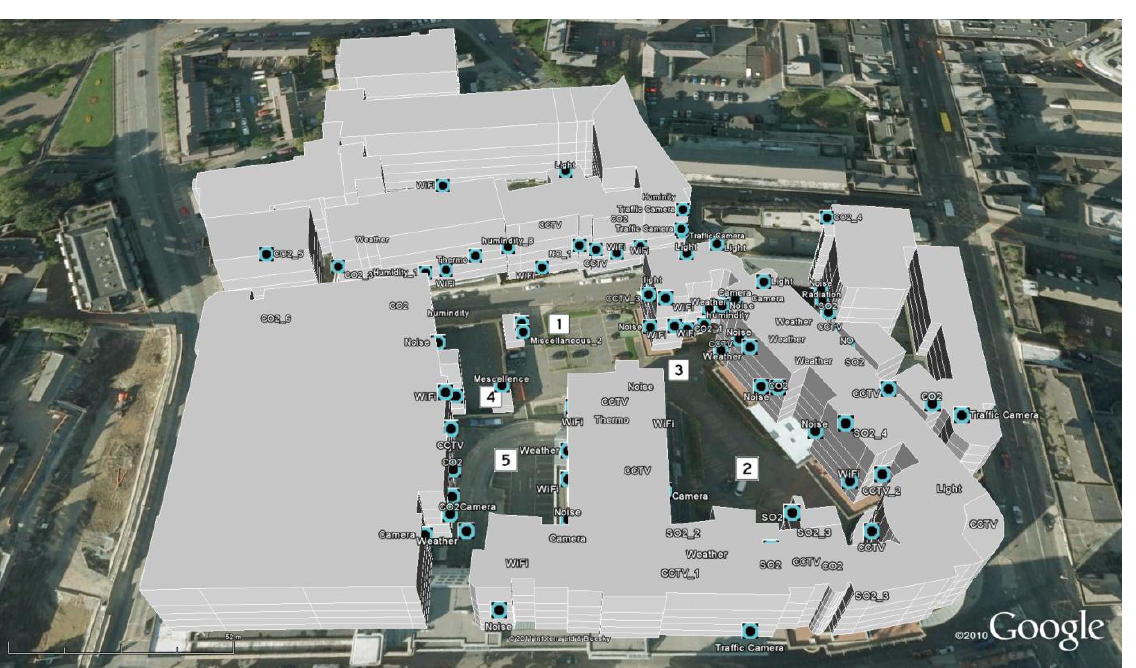
Figure 10. 3D model of university campus affixed with 100 simulated environmental